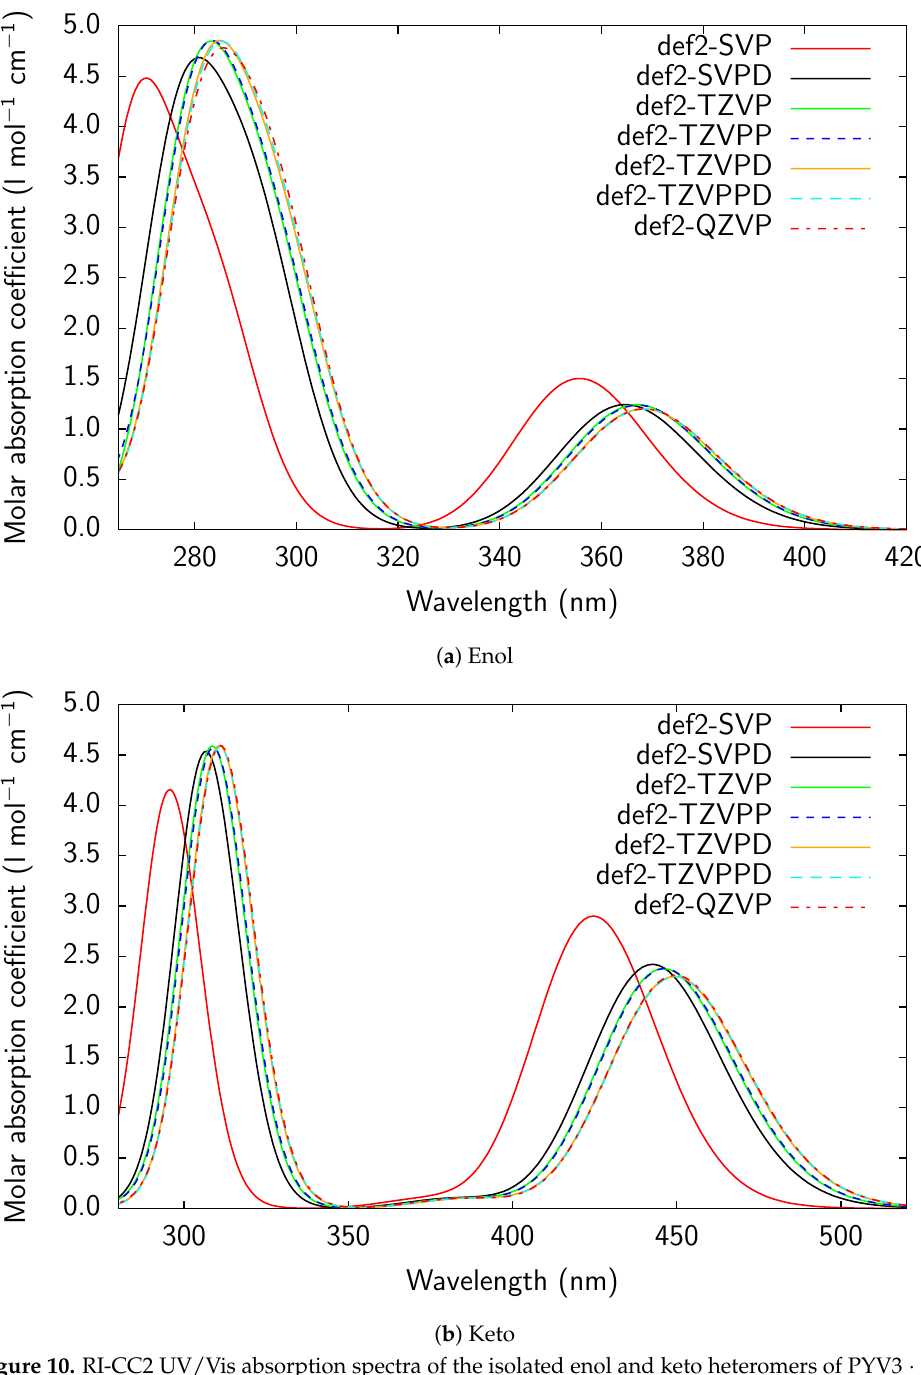
Figure 10. RI-CC2 UV/Vis absorption spectra of the isolated enol and keto heteromers of PYV3 · I2but, PYV3 + I2but [PYV3 · I2but], as a function of the basis